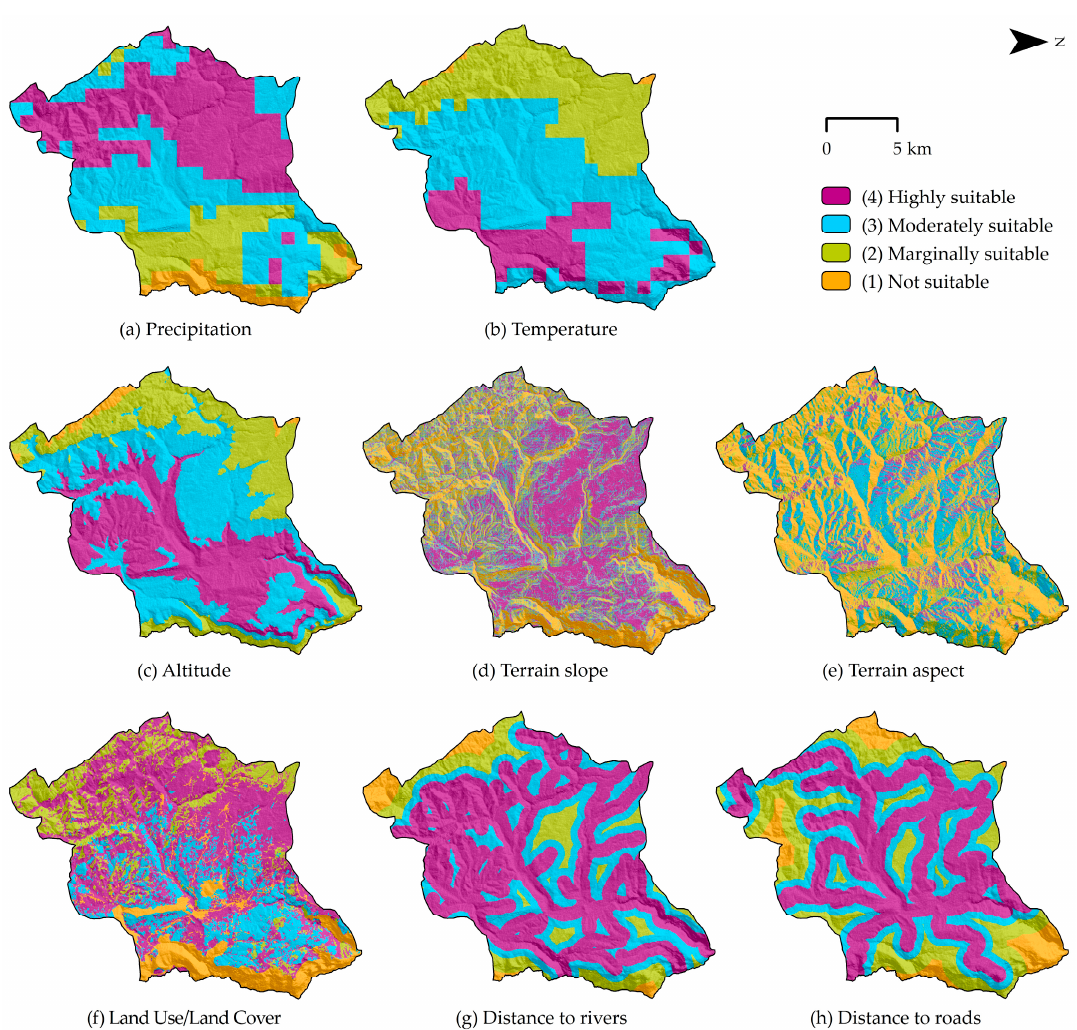
Figure 4. Thematic maps for climatological subcriteria ( a , b ), topographical subcriteria ( c – e ) and socioeconomic subcriteria ( f – h ) for land suitability modelling for potato cultivation in the Jucusbamba and Tincas microwatersheds (Amazonas, NW Peru). Table 1. Subcriteria reclassification and punctuation for land suitability modelling for potato cultivation in the Jucusbamba and Tincas microwatersheds (Amazonas, NW